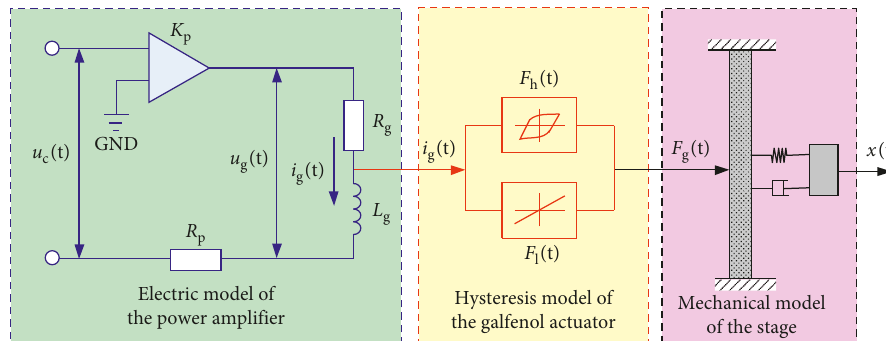
Figure 2: Electromechanical coupling model of the